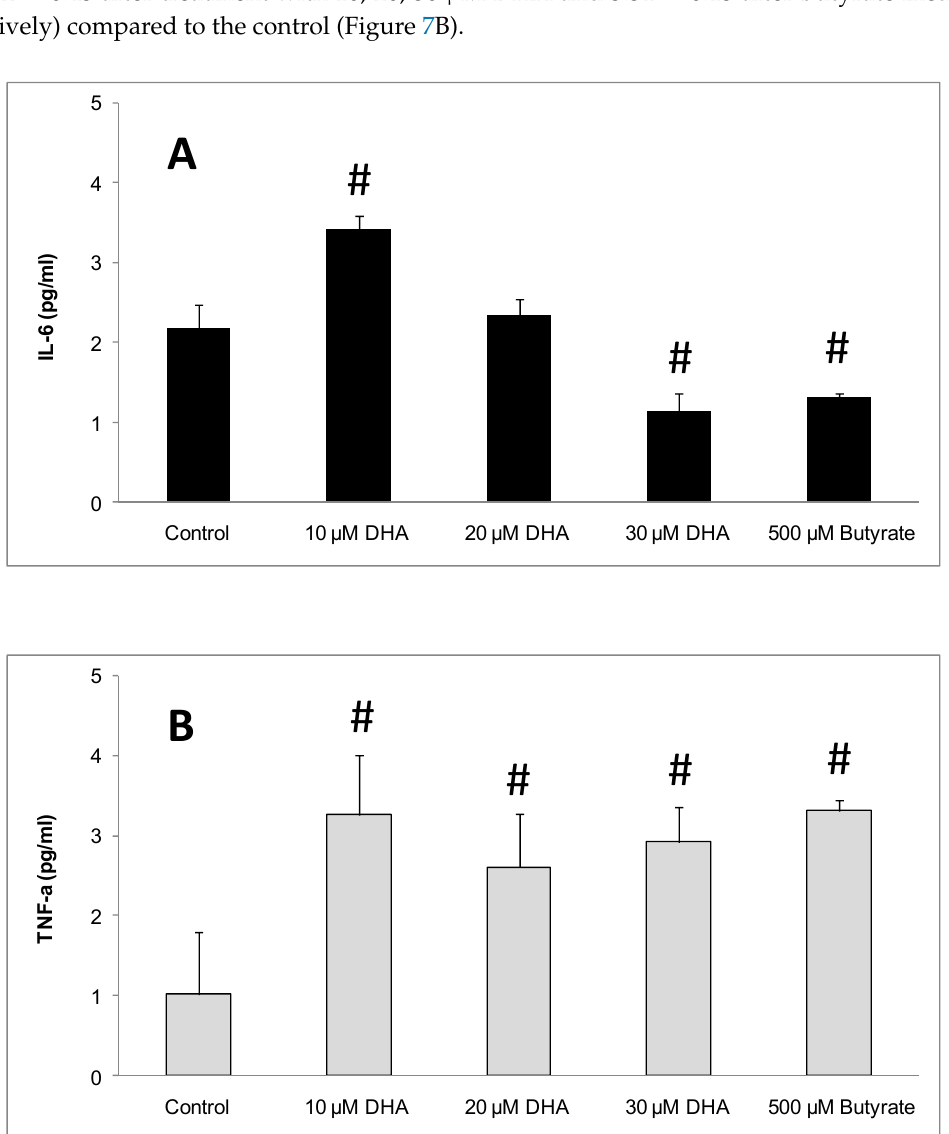
Figure 7. Effect of DHA on EoL-1 cells and IL-6 and TNF- α production. ( A ) IL-6 levels from EoL-1 cells culture medium in the absence (control) or presence of 10, 20, 30 µ M DHA and 500 µ M butyrate by ELISA analysis ( n = 3, in triplicates). ( B ) TNF- α levels from EoL-1 cells culture medium in the absence (control) or presence of 10, 20, 30 µ M DHA and 500 µ M of butyrate by ELISA analysis ( n = 3, in triplicate). The symbol # denotes statistically significant differences of p < 0.05 versus control. t -Test analysis for independent samples was applied by Statistica software.